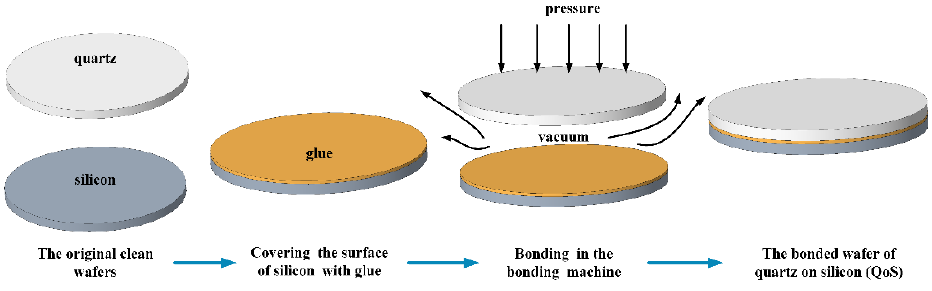
Figure 7. The fabrication process of auxiliary bonding.